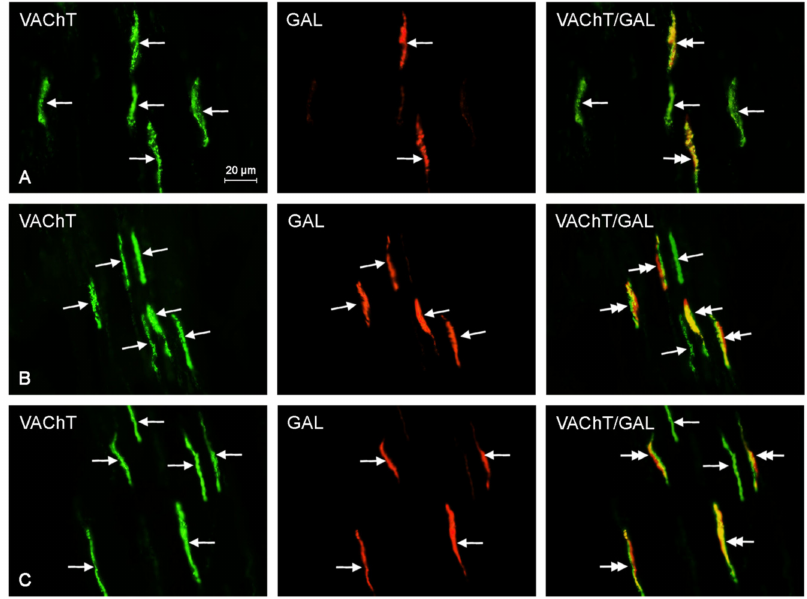
Figure 5. Representative images of immunocytochemical localization of VAChT- and GAL-immunoreactive nerve fibers in intrahepatic sympathetic nerves (arrows) of the control (CTRL; ( A )), E1—experimental group 1 (low dose of bisphenol A; ( B )), and E2—experimental group 2 (high dose of bisphenol A, ( C )); VAChT or GAL-IR nerve fibers are indicated with arrows, VAChT and GAL-IR nerve fibers are indicated with double-headed arrows; scale bars in all figures; 20 µ